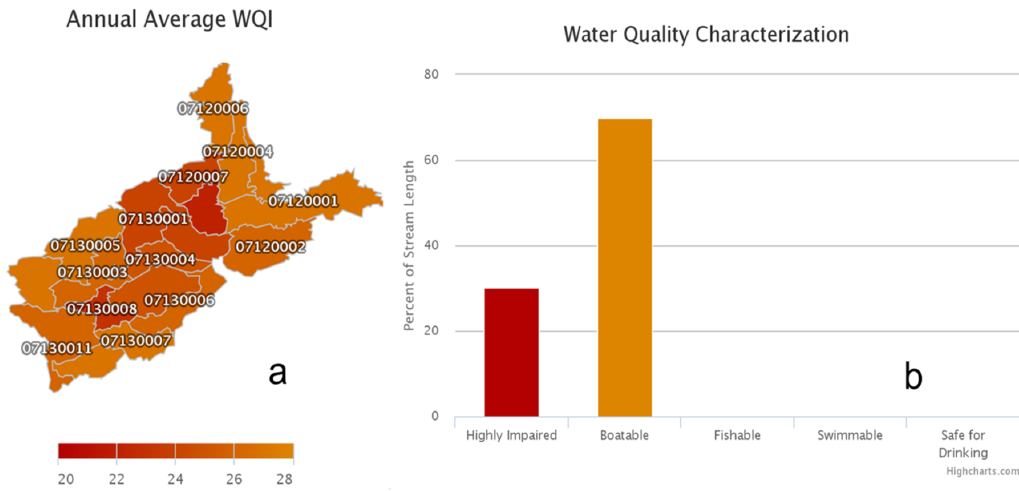
Figure 14. Water quality characterization in IRW.